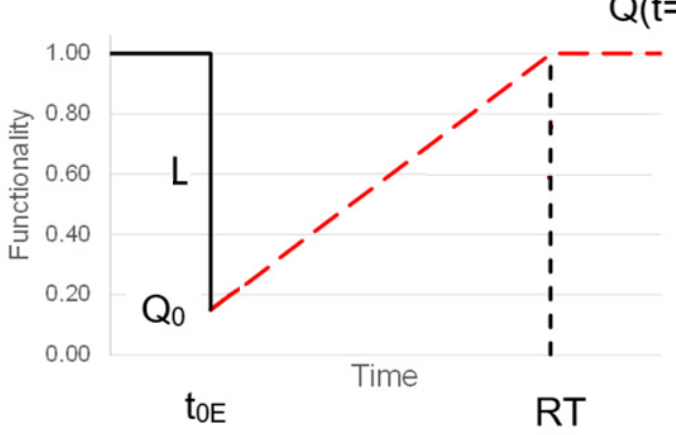
Figure 1. Resilience calculation (L= losses; RT = repair time; Q = functionality).